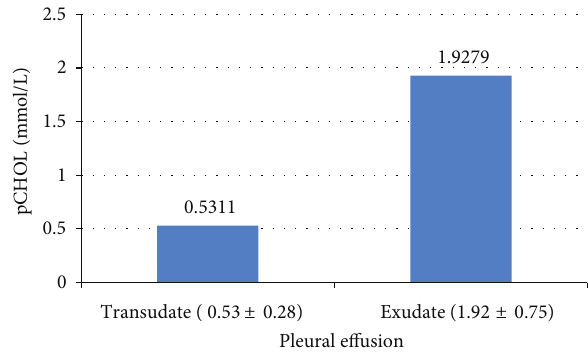
F 1: Distribution of type of pleural effusion.